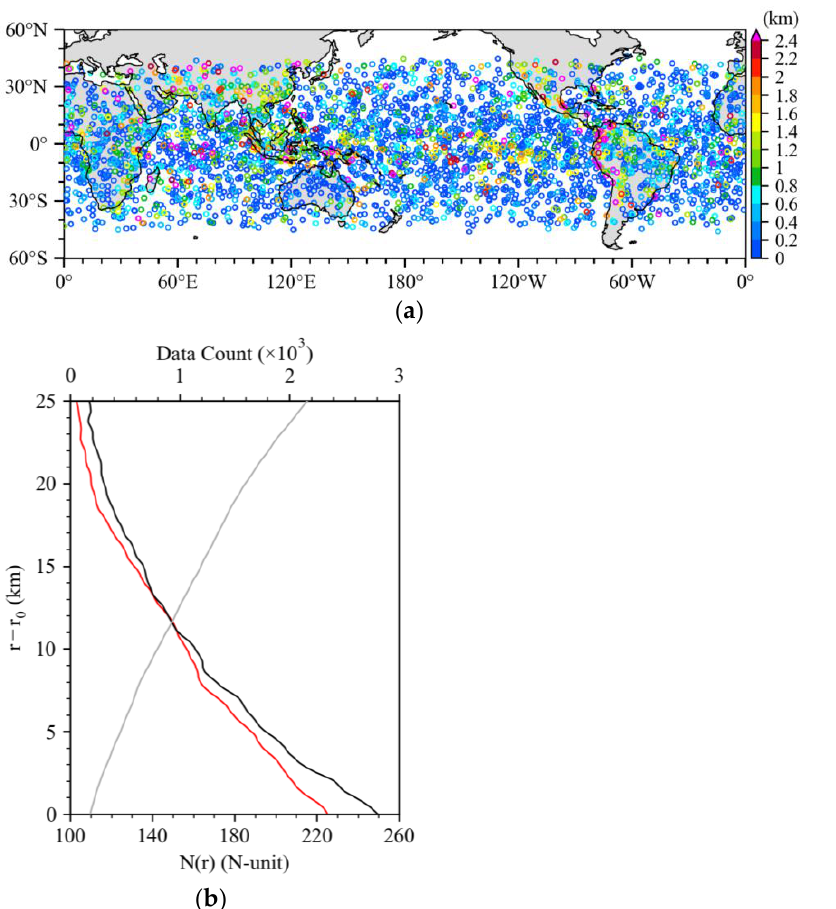
Figure 6. ( a ) Spatial distribution of COSMIC-2 observations of RO profiles on 1 August 2020, in which the lowest height from the Earth surface is indicated in colors. ( b ) Vertical profiles of spherically symmetric refractivity N ( r ) from the COSMIC-2 RO observations (red curve) and the ERA5 reanalysis (black curve). Also indicated is the COSMIC-2 data count (gray curve, top x-axis) between 45°S and 45°N on 1 August 2020.